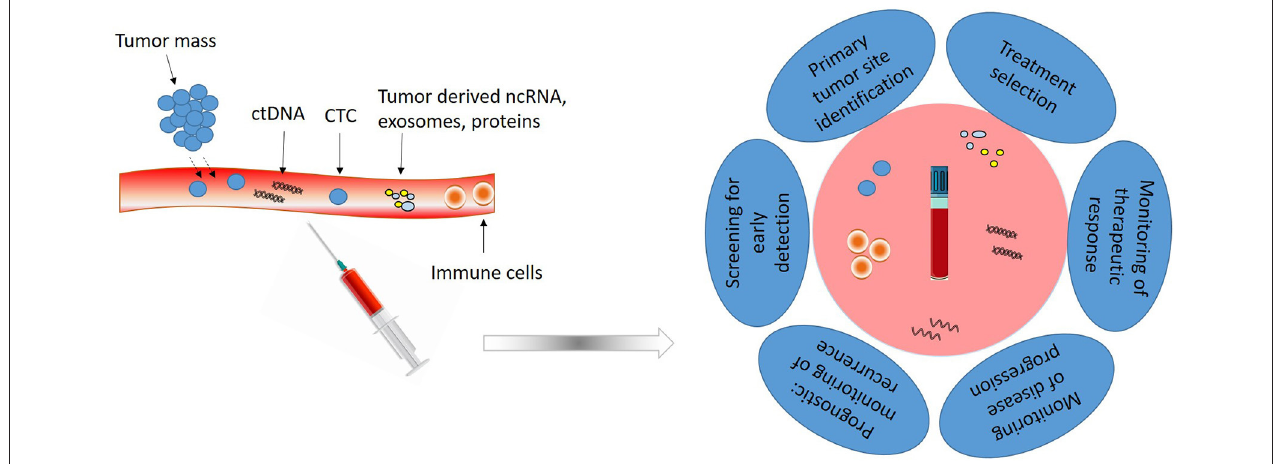
FIGURE 1 | Liquid biopsy composition and utility. Liquid biopsy obtained from peripheral blood is composed of circulating tumor cells (CTCs), circulating tumor DNA (ctDNA), non-coding RNAs (ncRNAs) and different tumor derived proteins and vesicles. Analysis of these elements has clinical utility for early detection, treatment selection, real-time progression information and